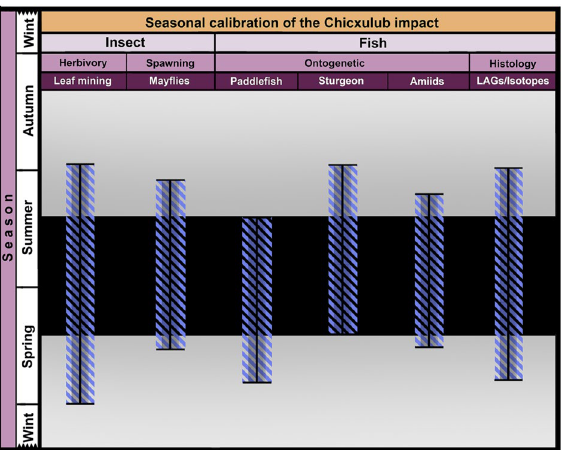
Figure 4. Seasonal calibration of the Chicxulub impact. Correlated ranges of seasonal insect behavior, inferred time of year based on sub-yearling fish fossil size ranges, and histological data (visual and isotopic) provide a refined temporal estimate for the Chicxulub impact